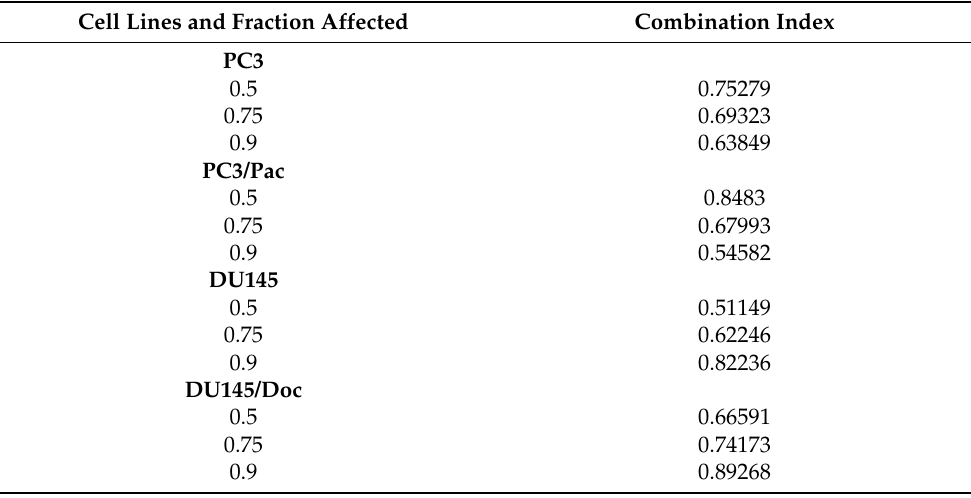
Table 2. Combination Index (CI) values of MK2206 and Lapatinib for wild-type and taxane- resistant